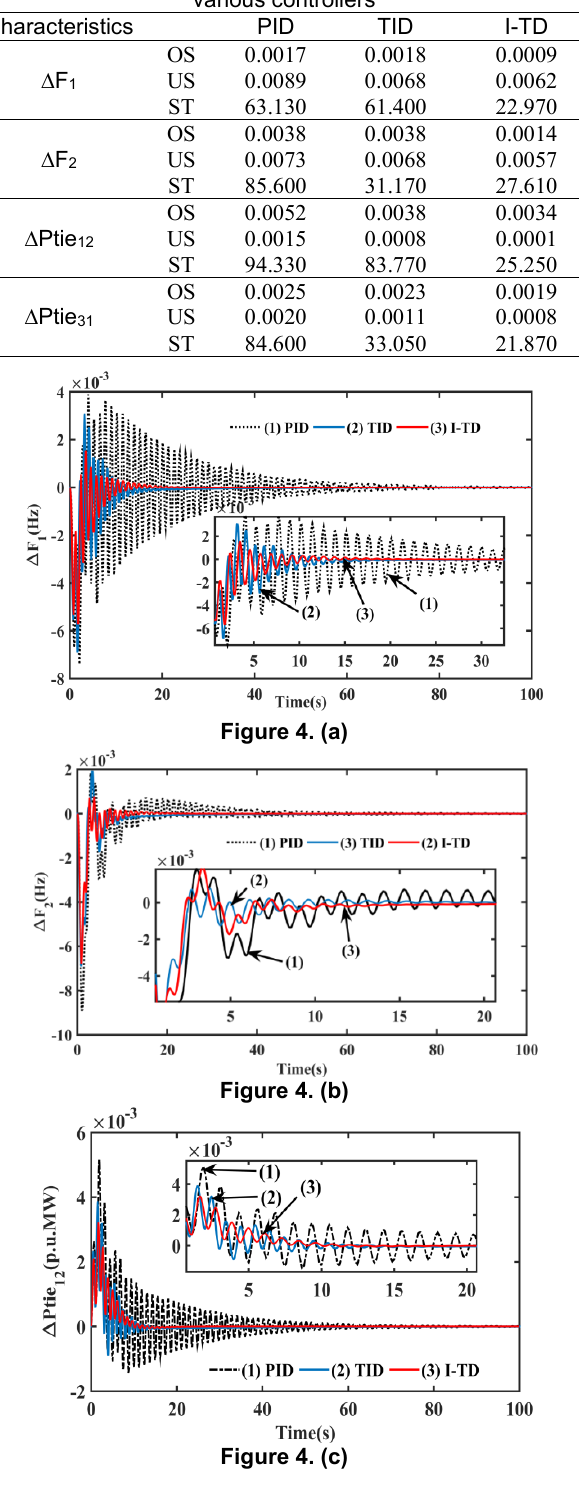
Table 1. (b) Comparison of system dynamic responses with